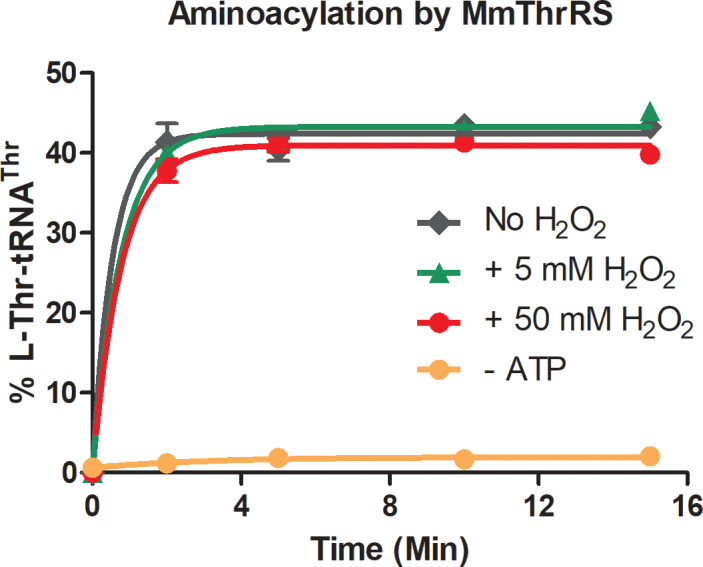
H2O2 does not affect the synthetase activity of ThrRS.Threonylation of 2 µM tRNAThr by 400 nM of M. musculus ThrRS in presence and absence of H2O2. Reaction without ATP acts as a negative control.